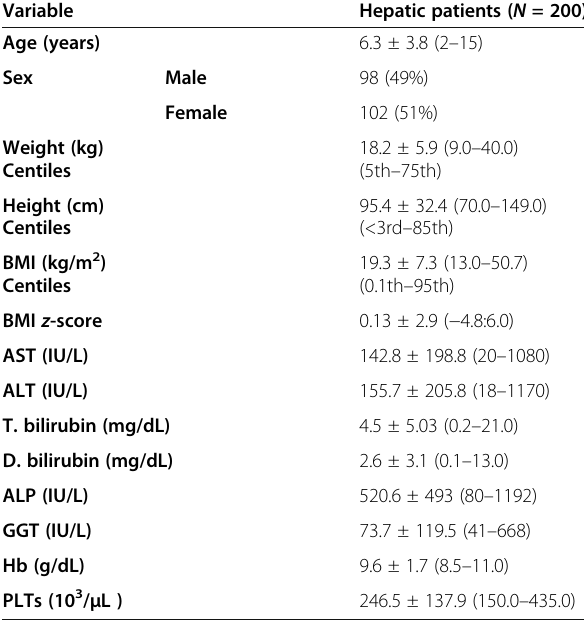
Table 1 Clinical and laboratory characteristics of the study group at the time of liver biopsy